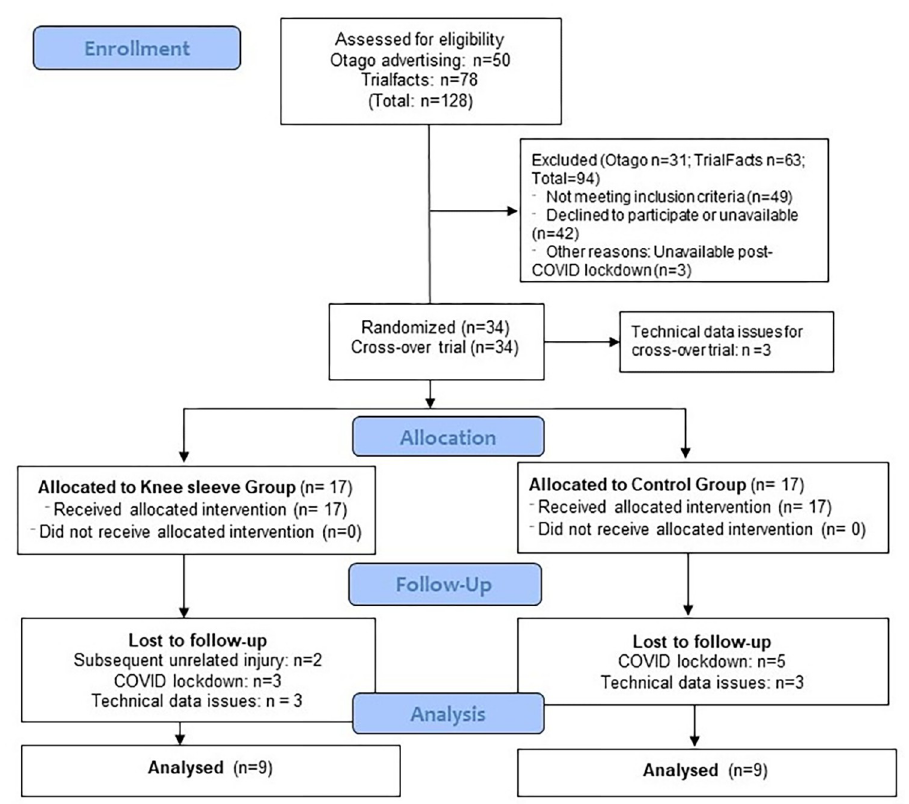
Fig 1. CONSORT flowchart of participant recruitment, allocation and